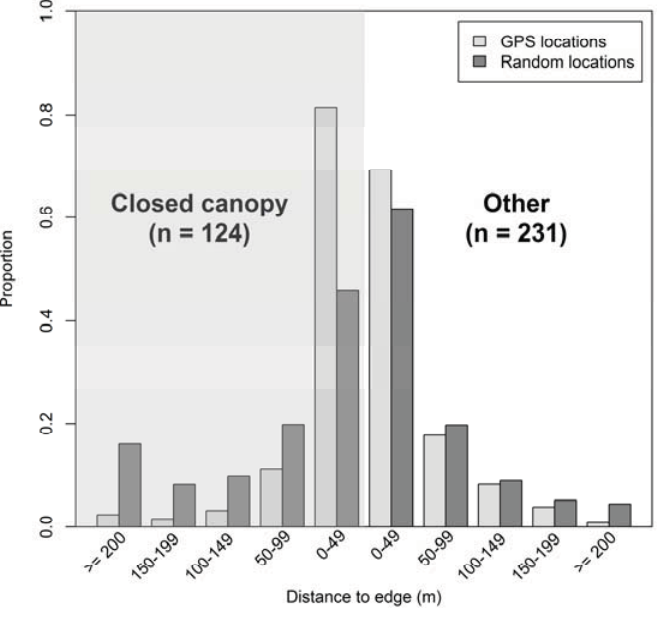
Figure 2. Proportions of elephant locations (total n = 355) and random locations (n = 1,000) in categories of the Euclidean distance (m) to the forest edge, depending on whether elephants were within or outside (“other”) closed canopy forest (shaded